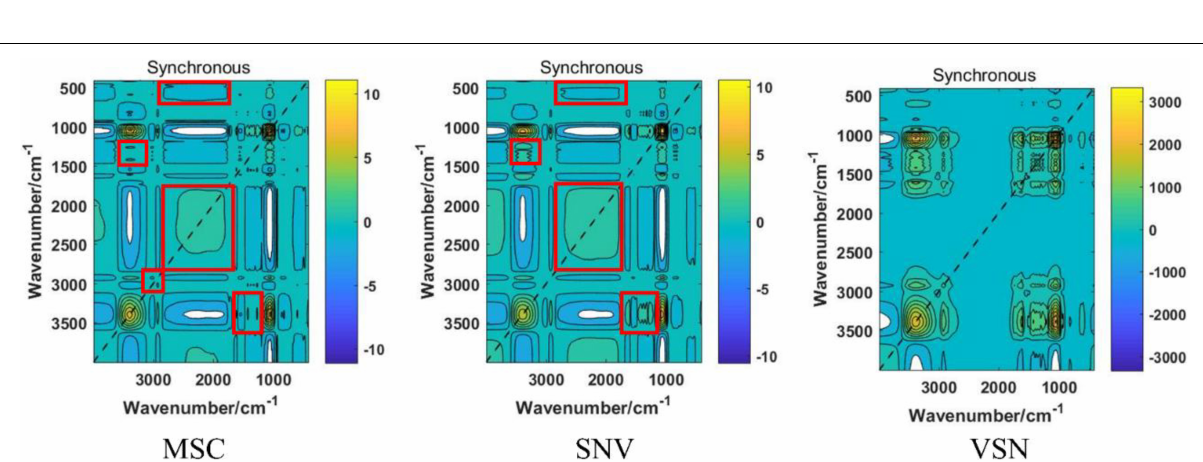
Frontiers in Plant Science |